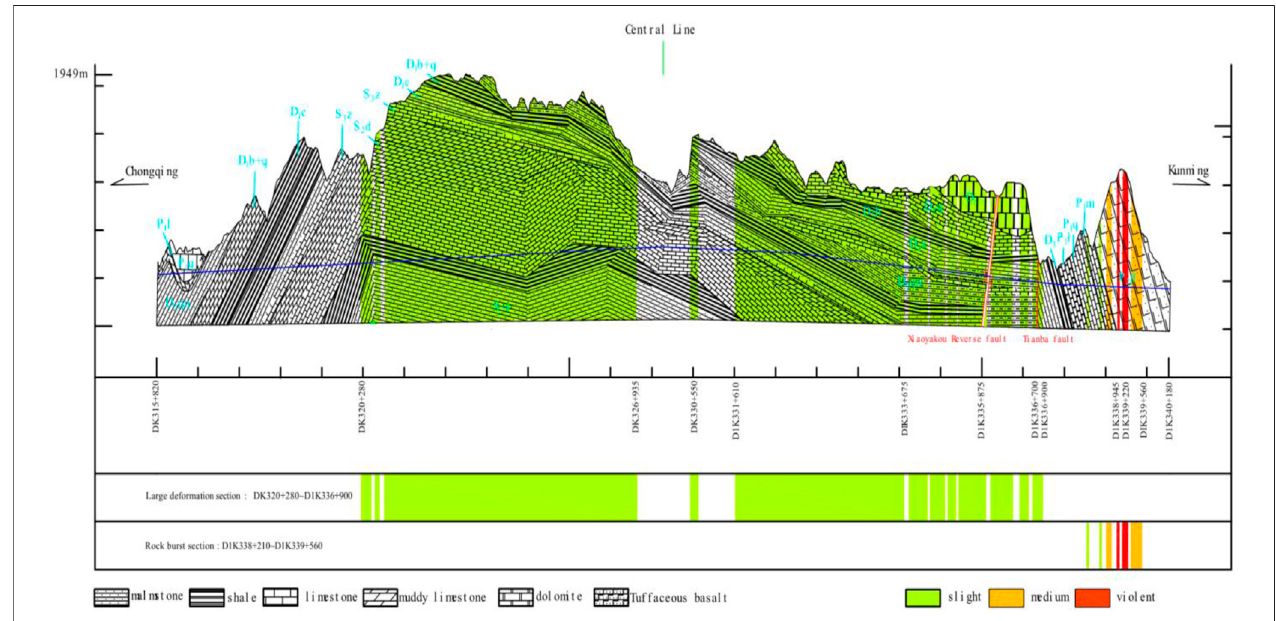
FIGURE 7 | Forecast of rock burst risk section and large deformation section in the